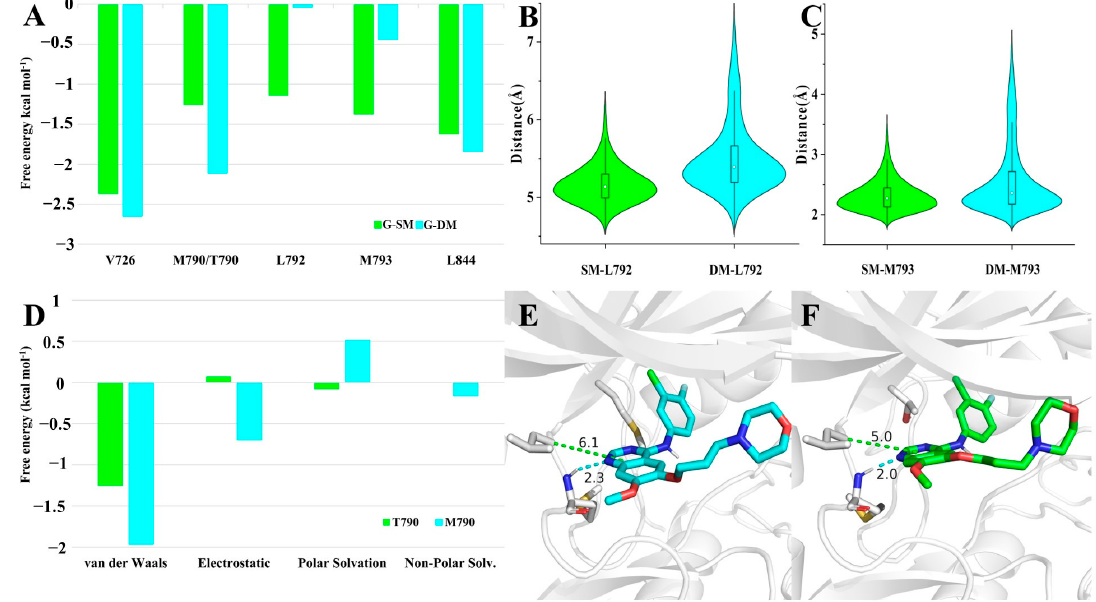
Figure 4. ( A ) Residues contributed more than 1.0 kcal mol − 1 in any SM (colored green) or DM (colored cyan) system by energy decomposition. ( B ) The distribution of the distance between C α of L792 and the geometry center of Gefitinib’s pyrimidine ring in SM and DM, respectively. ( C ) The distribution of the distance between the main chain amino hydrogen of M793 and the nitrogen of Gefitinib’s pyrimidine ring in SM and DM, respectively. ( D ) van der Waals, electrostatic, polar solvation, and non-polar solvation contributed M/T790. The cluster structure of Gefitinib at the pocket of SM ( E ) and DM ( F ).